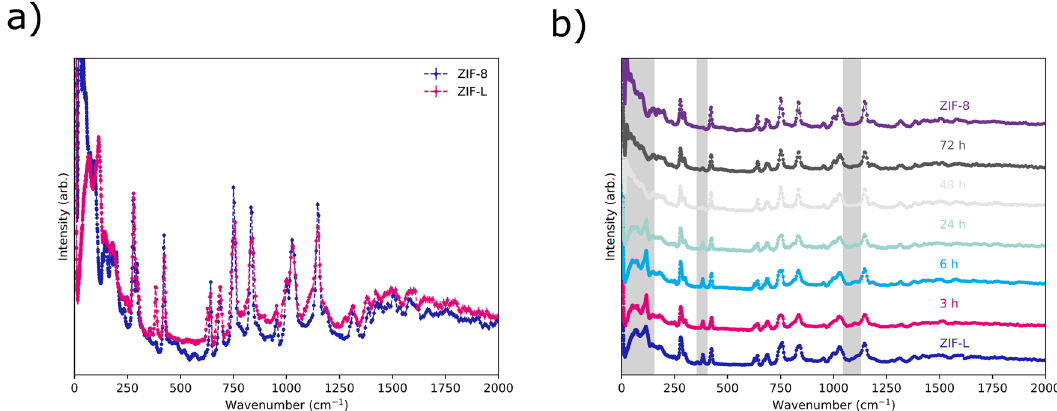
Fig. 3 INS data showing the phase change. a INS spectra collected on reference ZIF-8 and as synthesised ZIF-L. b INS spectra of samples of ZIF-L after various washing times with methanol. Grey areas are for visual guidance only. Also included is a reference pattern of ZIF-8 made by literature